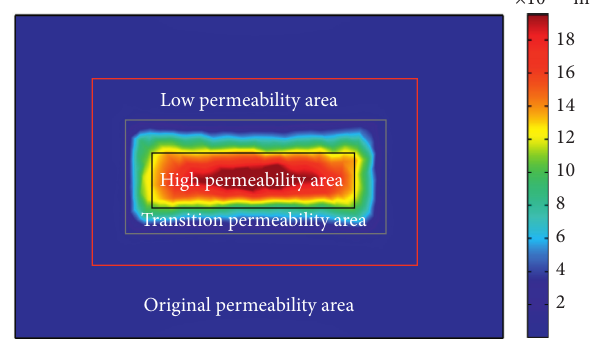
Figure 10: Permeability characteristics of #3 coal